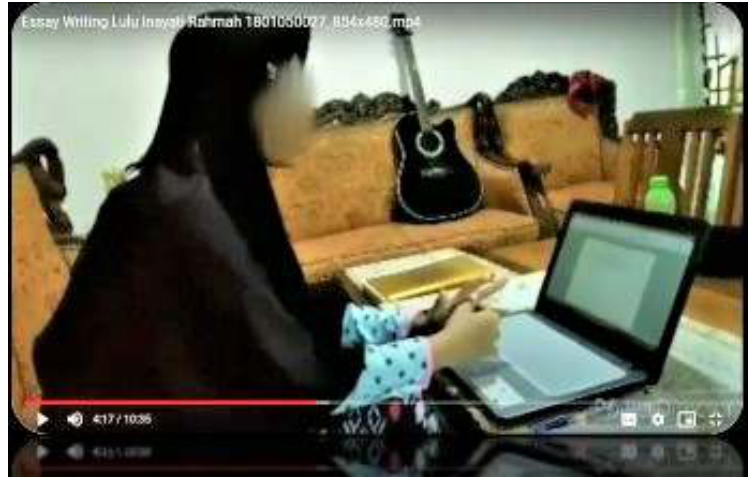
Figure 3. A sample video of student’s essay writing